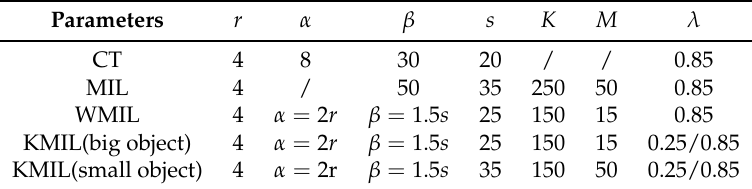
Table 1. The parameters for the MIL, CT, WMIL and KMIL trackers. r is the radius for positive bag, α and β are the radius for the negative bag, s is for the searching area, K is the number of the weak classifiers, M is the number of the selected most discriminative weak classifiers. λ is the learning rate.